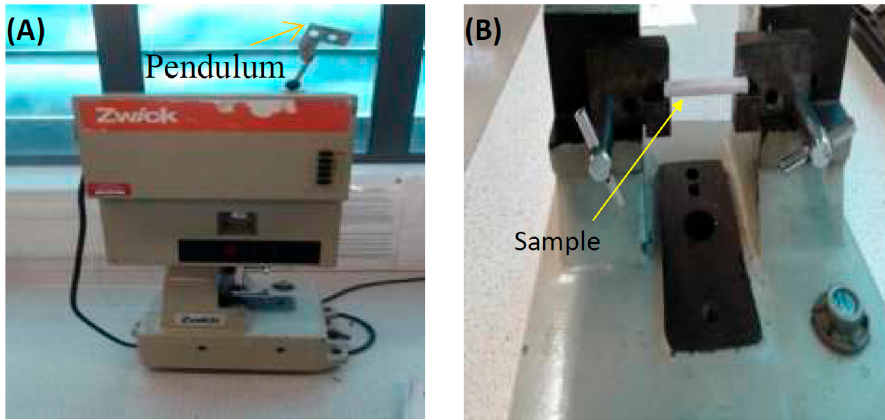
Figure 1. ( A ) Impact test machine and ( B ) position of sample in the machine before the